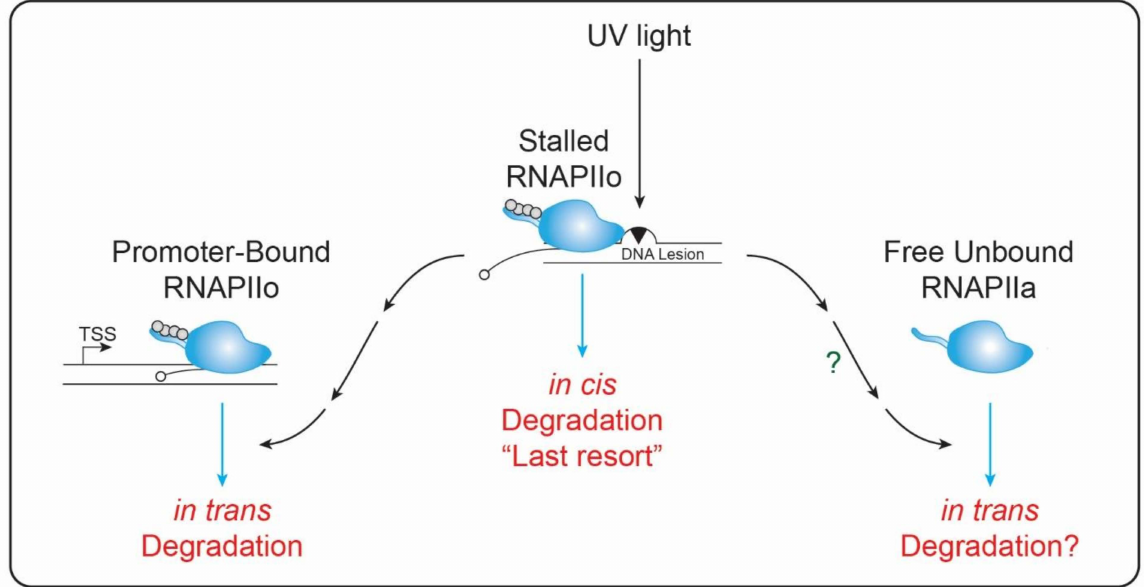
Figure 2. Possible RPB1 degradation pathways. RPB1 degradation upon DNA damage induction has been historically associated with a last resort, where RPB1 is degraded in cis to the DNA lesion, in order to facilitate access to TC-NER repair factors [8] ( center ). More recently, in trans degradation of promoter-proximal paused RPB1 has been proposed [30,31] ( left ) and VCP/p97 segregase independent degradation of RPB1 were also shown, opening the possibility of chromatin unbound RBP1 degradation [32] ( right